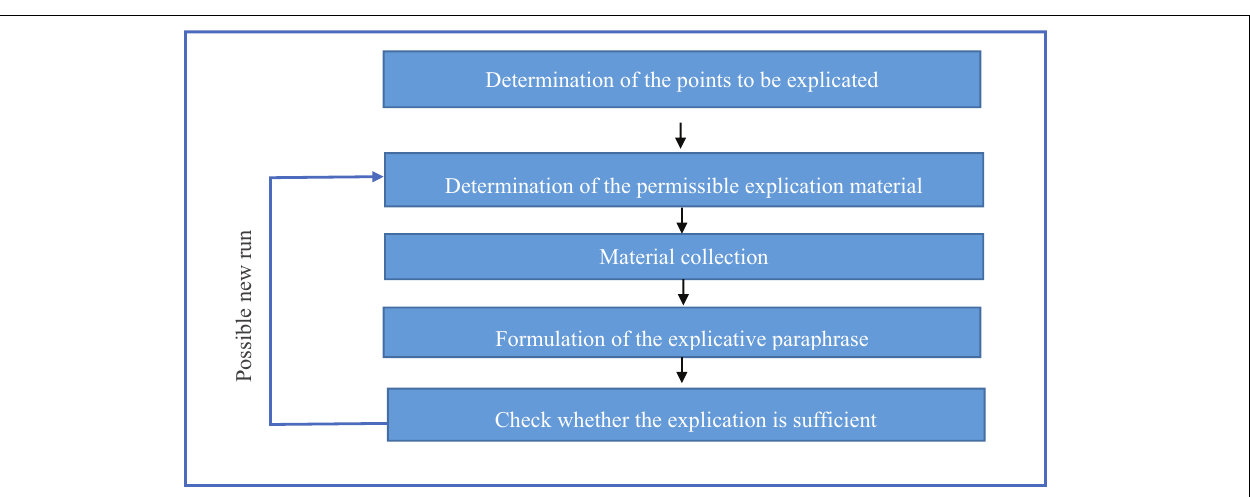
FIGURE 2 | Process model of the explicit qualitative content analyses (Mayring,